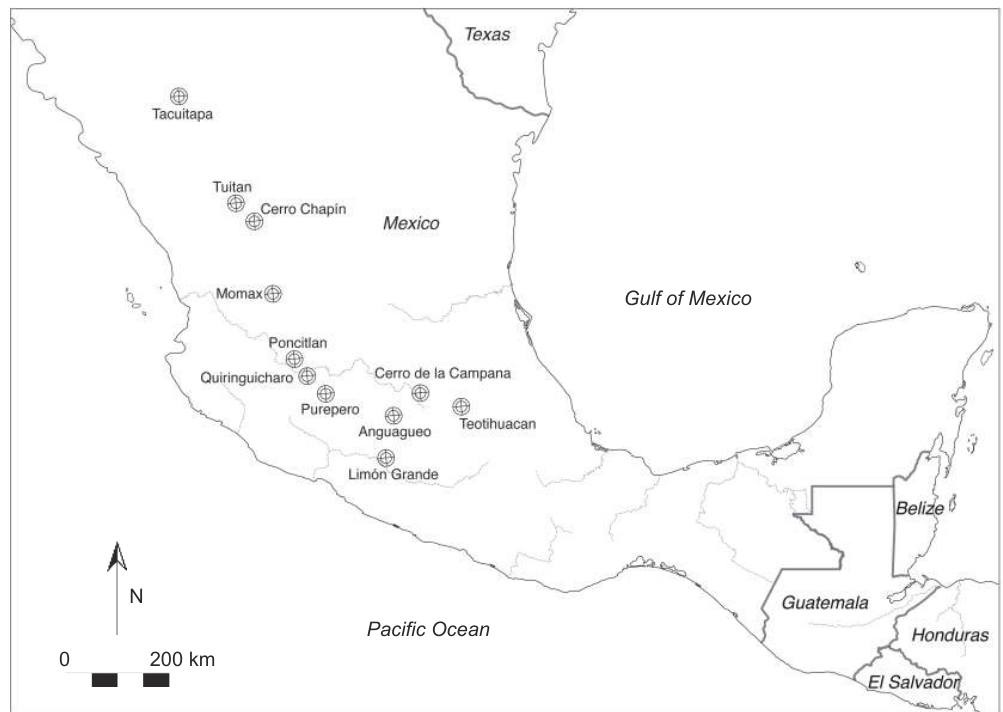
Fig. 11 Geographic distribution of pecked crosses in